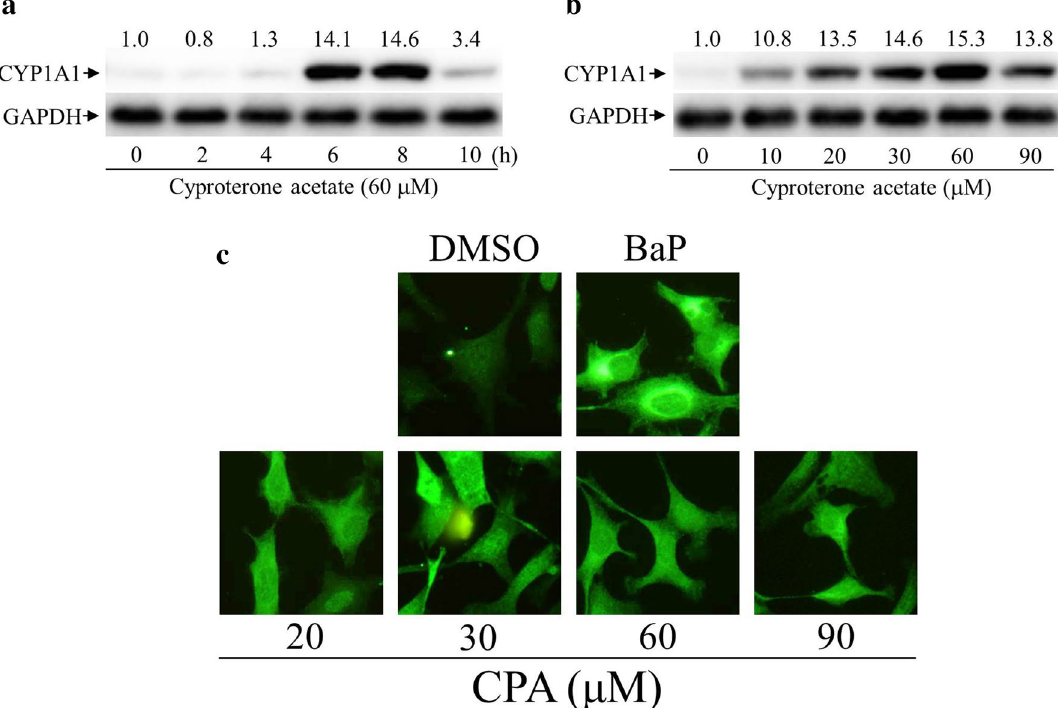
Figure 3. Expression profiles of cytochrome P450 1A1 (CYP1A1) protein induced by cyproterone acetate (CPA) in mouse cells. ( a ) Hepa-1c1c7 cells were treated with CPA (60 μM) for 2–10 h. ( b ) Hepa-1c1c7 cells were treated with CPA (10–90 μM) for 6 h. Expression of the CYP1A1 protein was analyzed by Western blots. The CYP1A1 protein levels revealed by Western blotting were quantified and standardized against the amounts of β-actin or GAPDH protein. The relative levels of CYP1A1 expression are indicated on the top of the bands. ( c ) CPA and benzo[ a ]pyrene (BaP)-induced CYP1A1 expression as revealed by immunofluorescence images. Hepa- 1c1c7 cells were treated with CPA (20–90 μM) and BaP (10 μM) for 6 h. Afterward, cells were fixed with ethanol. Expression of the CYP1A1 protein was probed using an antibody against CYP1A1, as revealed by fluorescence of a rabbit polyclonal secondary antibody to rabbit IgG-H&L (DyLight 488). Fluorescence emitted by cells was viewed using a fluorescence microscope, equipped with optical filters at excitation/emission wavelengths of 493/518